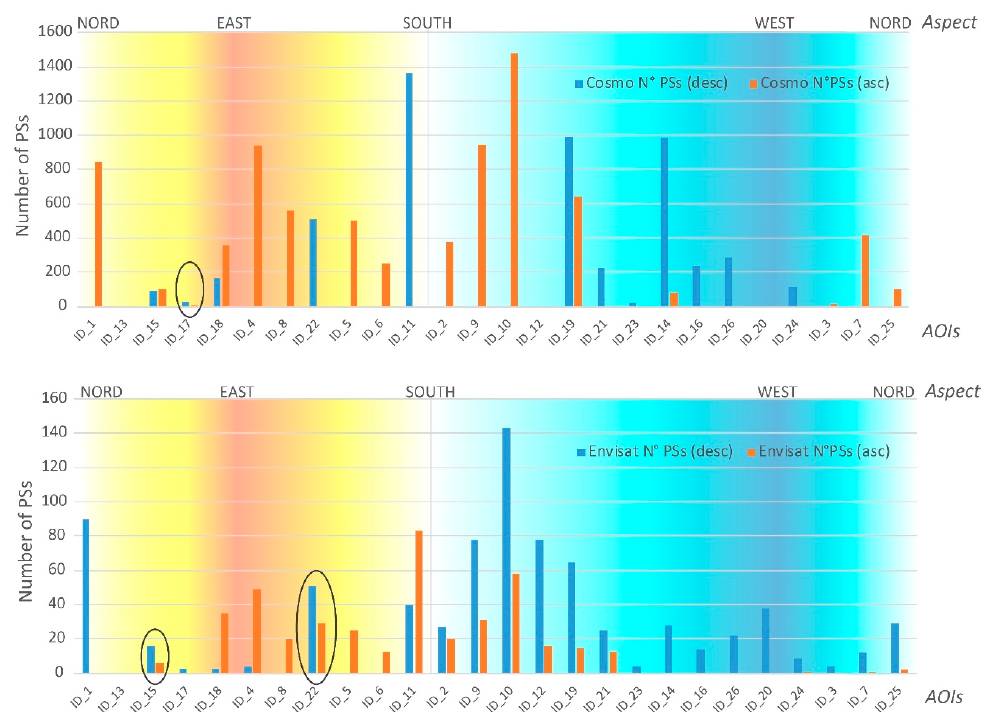
Figure 11. Number of PSs of COSMO-SkyMed and Envisat data-stacks compared with the aspect directions for each AOIs. The AOIs are ordered with respect to aspect direction, from north in a clockwise direction. Black ellipsis indicates the AOIs where the results don’t confirm the general rule of the SAR acquisition geometries (the same AOIs in red of Table 4).